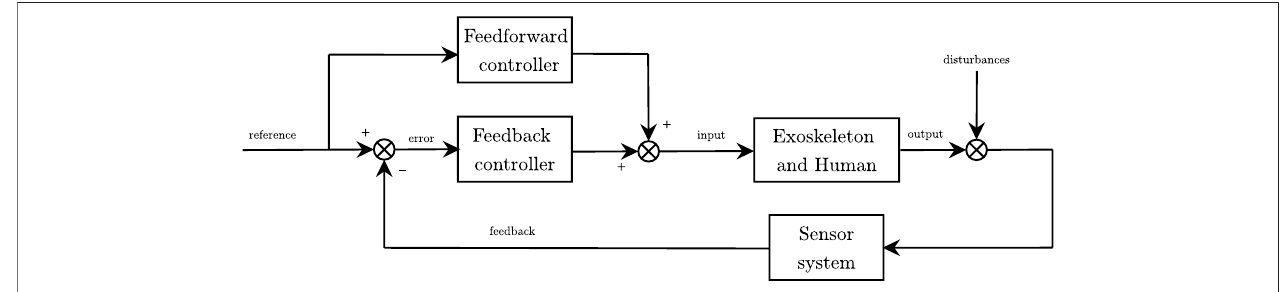
FIGURE 2 | General control scheme. Feedback control (impedance-based corrective assistance) and feedforward control (counterbalance assistance) sum up to compute the desired control